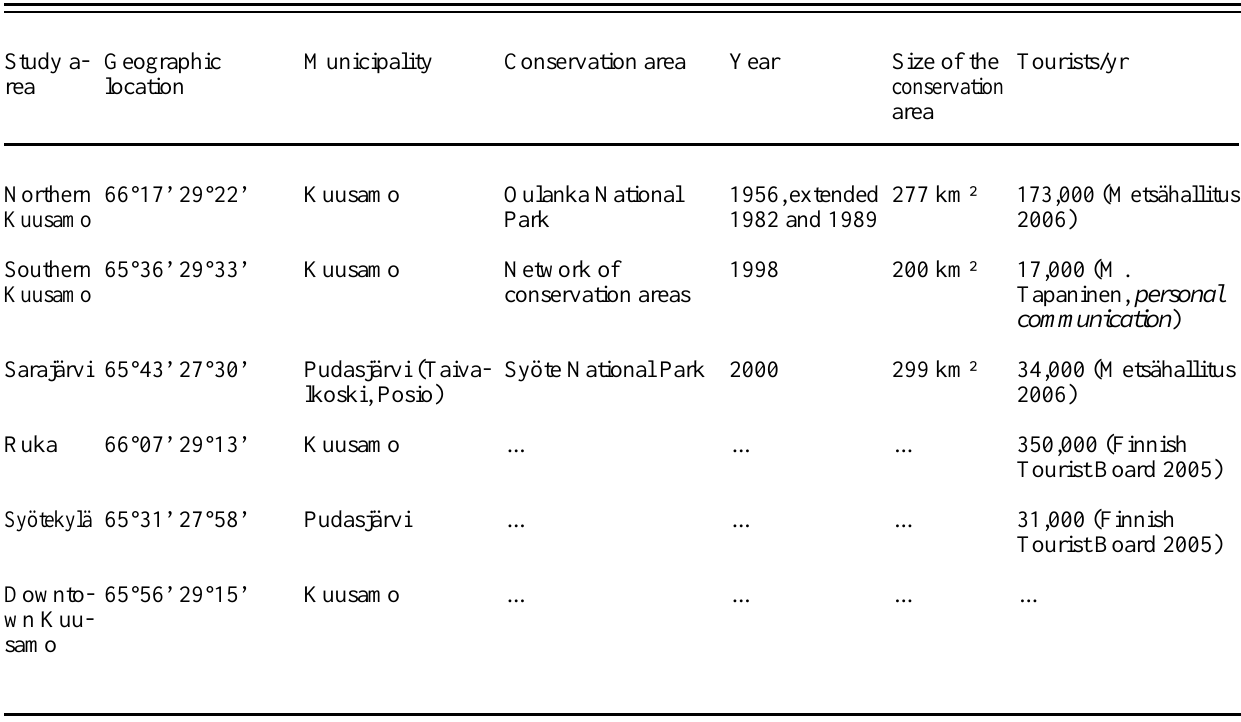
Table 1 . Description of residential area of respondents. Year represents the year that nature conservation was first established in the